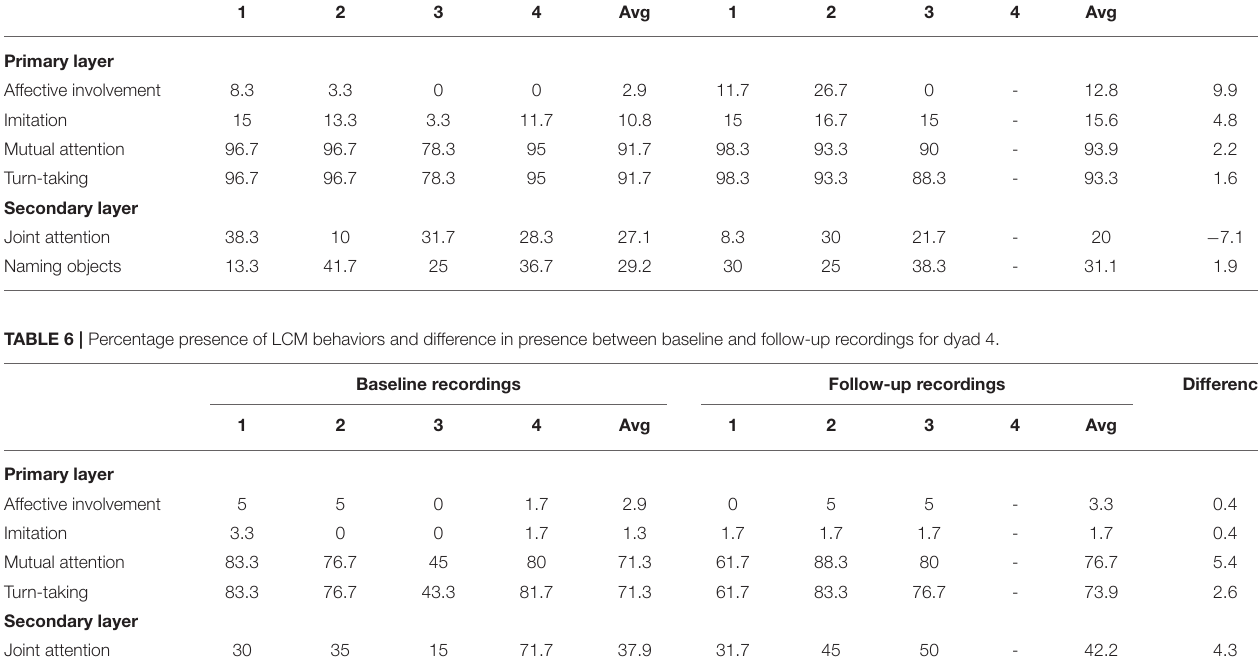
TABLE 5 | Percentage presence of LCM behaviors and difference in presence between baseline and follow-up recordings for dyad 3. Baseline recordings Follow-up recordings